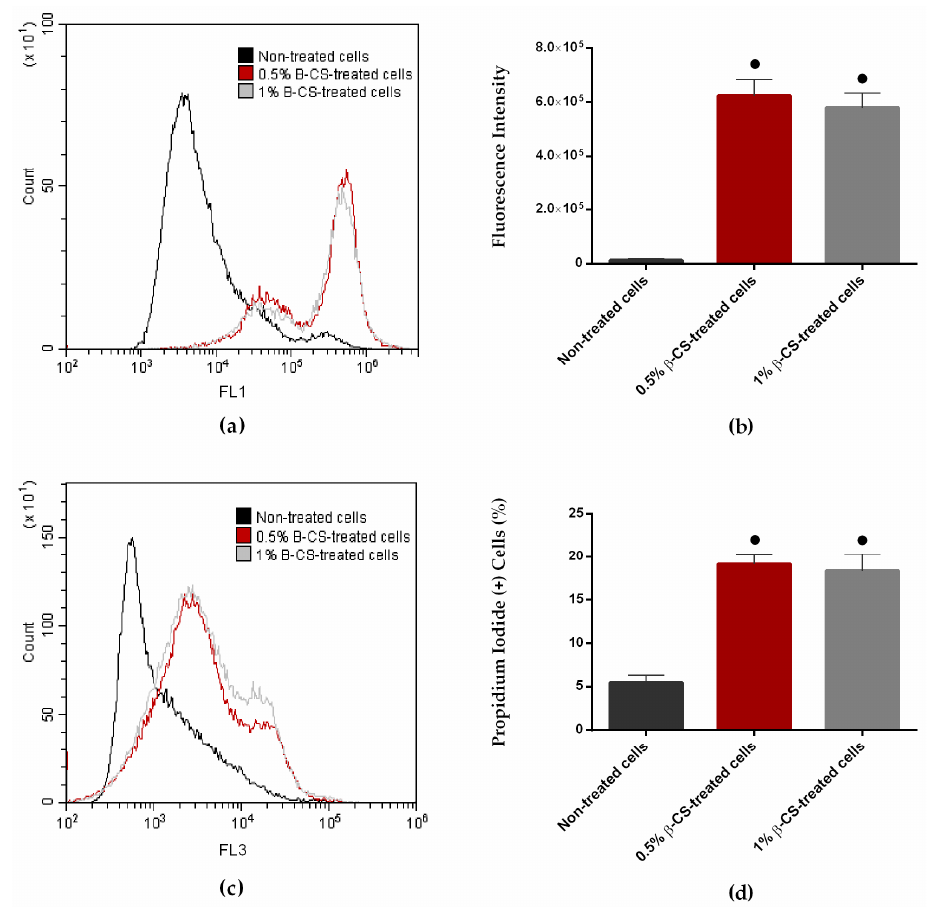
Figure 1. Representative flow cytometric histograms ( a , c ), the fluorescence intensity ( b ), and the percentage of propidium iodide-positive (PI (+)) cells ( d ) of C. marina non-treated ( ■ ) and treated with 0.5 ( ■ ) and 1% ( ■ ) β -CS for 24 h and stained with DiBAC 4 (3) (a membrane potential marker) ( a , b ) and PI (a membrane integrity marker) ( c , d ), respectively. The means ± standard deviations for two independent experiments are illustrated. Significant differences between treated cells and the control (non-treated cells) were evaluated using the non-parametric Mann-Whitney test and represented for p -values < 0.05 by ● .